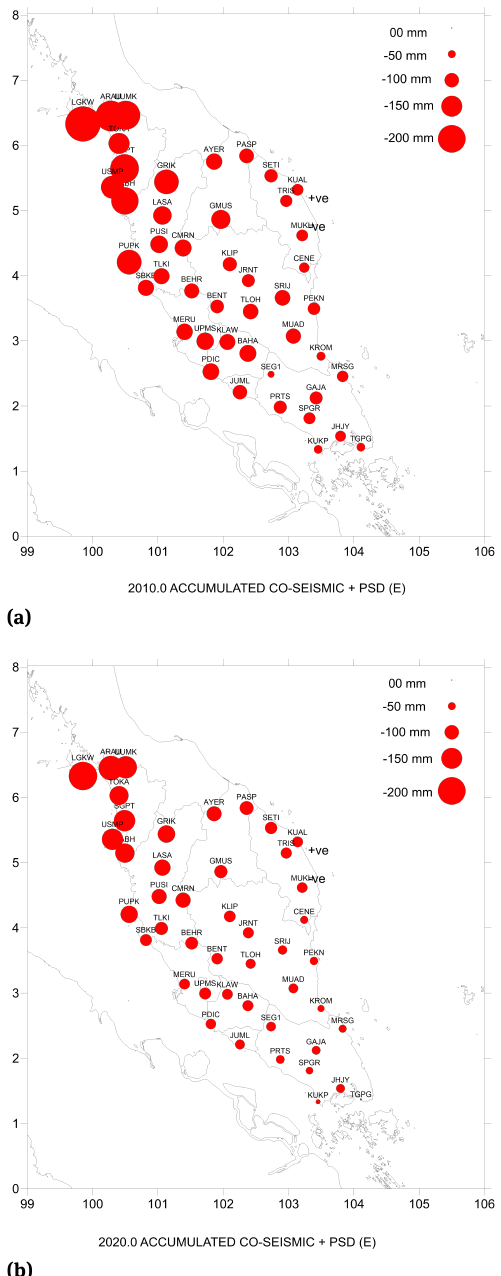
Fig. 14. East component of the total accumulated co-seismic+ PSD